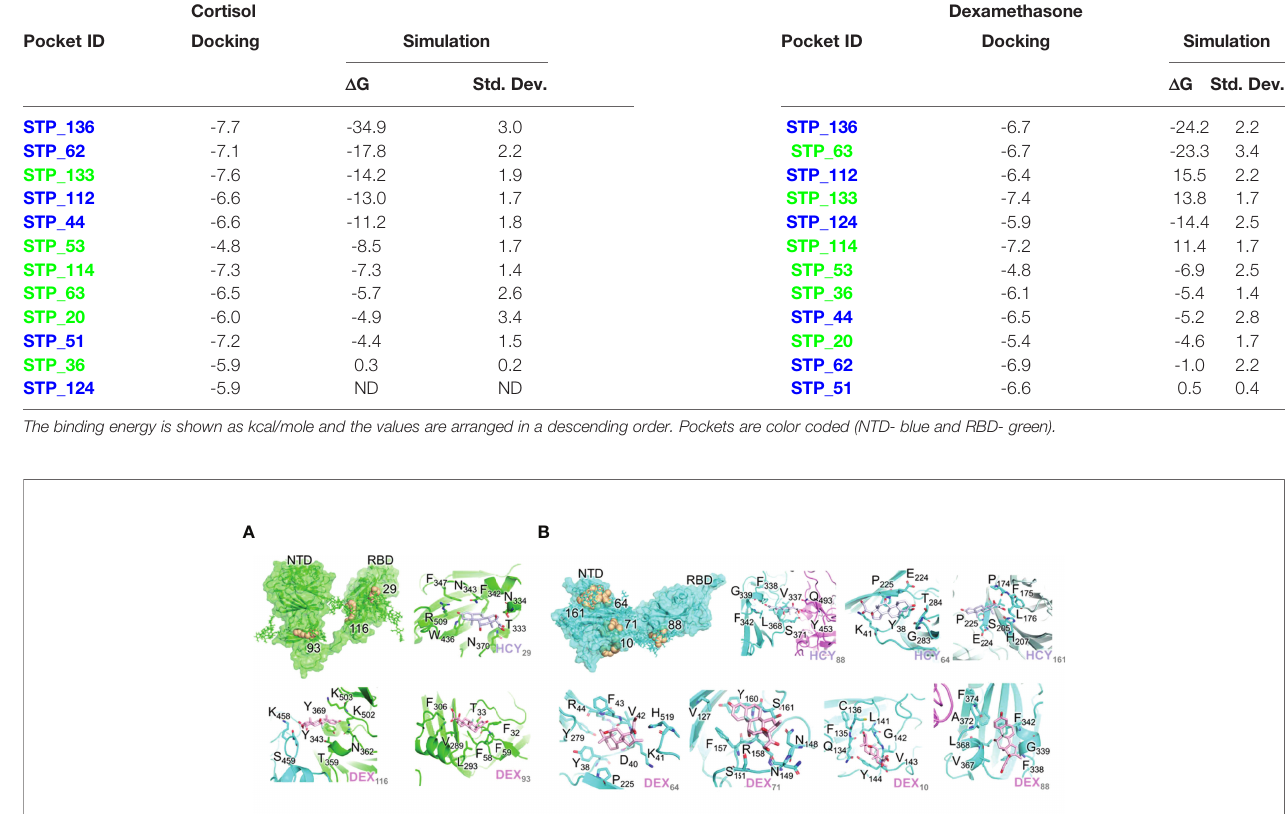
monomers do not make any contacts with each other in spike S1, no pockets could be expected. The two ligands can bind to the pocket STP_135 and STP_8, located at the interface between chain A and chain B, with high af fi nity ( Table 4 ; Figure 2A ). The interface between chains A and C could interact with high